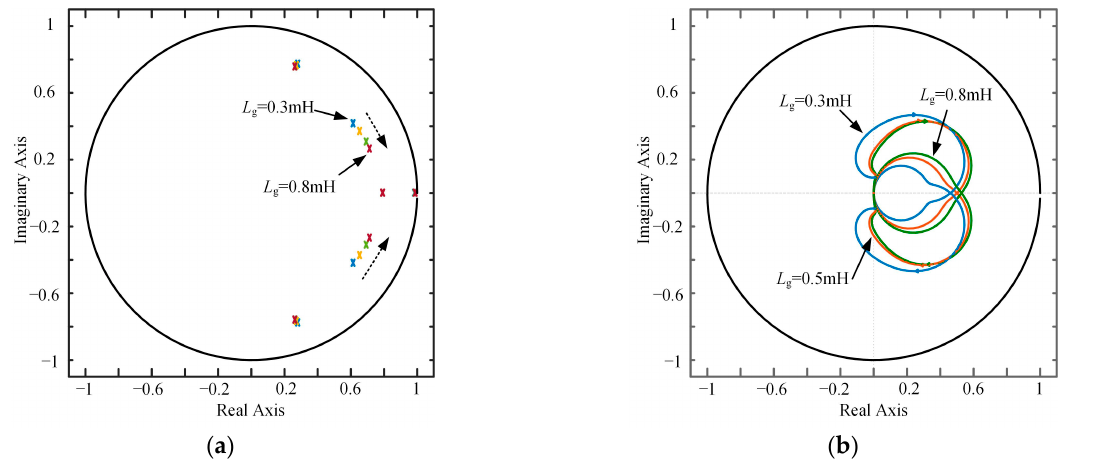
Figure 10. Stability analysis for the system with variable L g . ( a ) Pole map of H ( z ); and ( b ) locus of the vector | H ( e j ω T s )|.